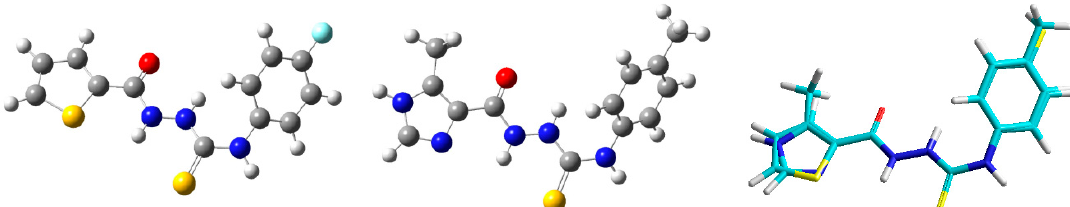
Figure 1. Left : Structure of previously reported 4-(4-fluorophenyl)-1-(thiophen-2-oyl)-Table 1. with potent inhibitory activity against proliferation of Toxoplasma gondii (IC 50 = 33.17 µ g/mL vs. > 500 µ g/mL for sulfadiazine) [36]. Middle : Geometry of representative model compound 18 ; remaining 4- arylthiosemicarbazides 2 – 7 , 10 – 17 , 19 – 22 share similar conformations. All structures were obtained from the Amber force field (HyperChem 8.0.3.) that was found to provide correct structures for this class of compounds [37]. Right: Superposition of 1 and 18 .